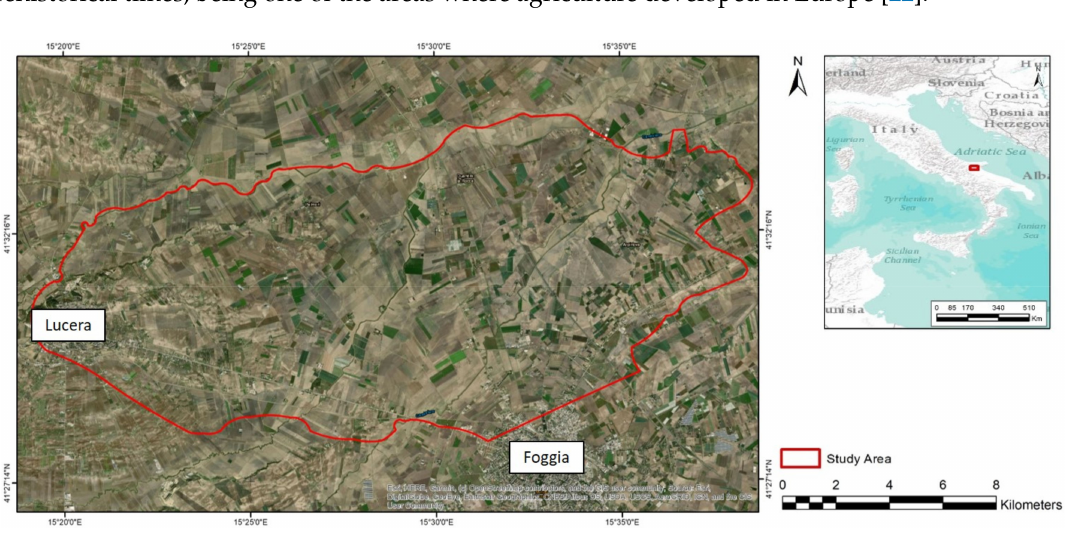
Figure 1. Study Area